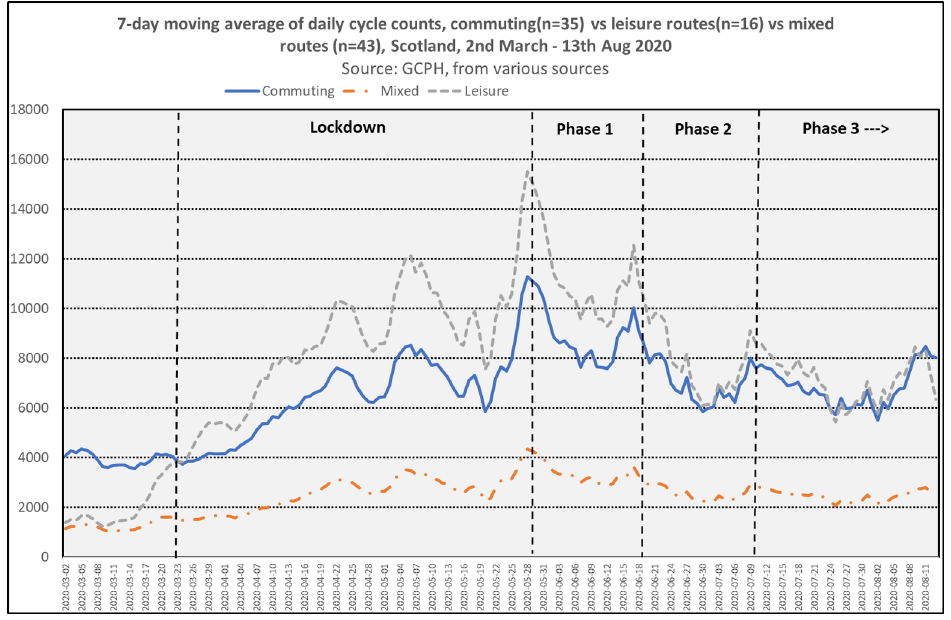
Figure 3: Seven-day moving average of daily cycle counts on commuting, leisure and mixed routes in Scotland, March 2–August 13,